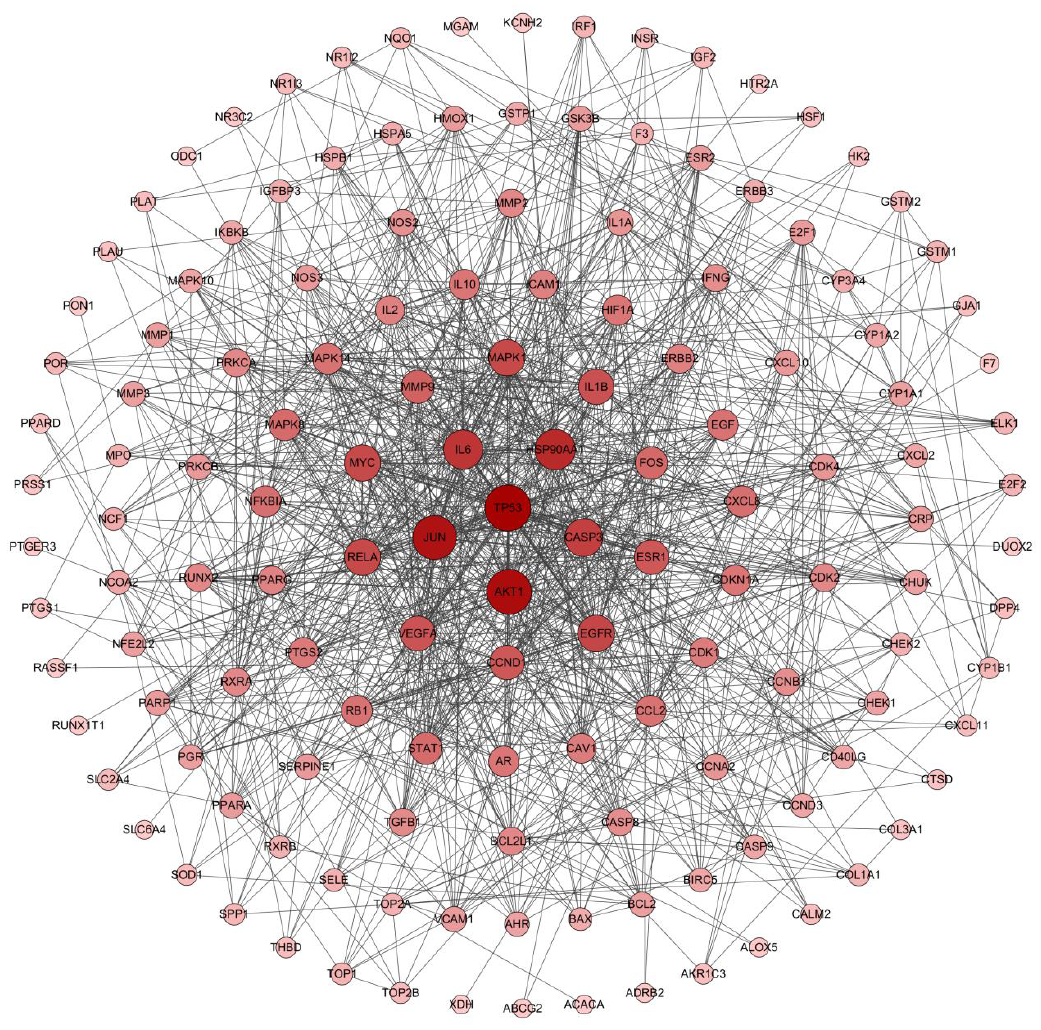
Figure 3. PPI network diagram. The darker the color, the higher the association of proteins with disease Edge: Represents the association between proteins.